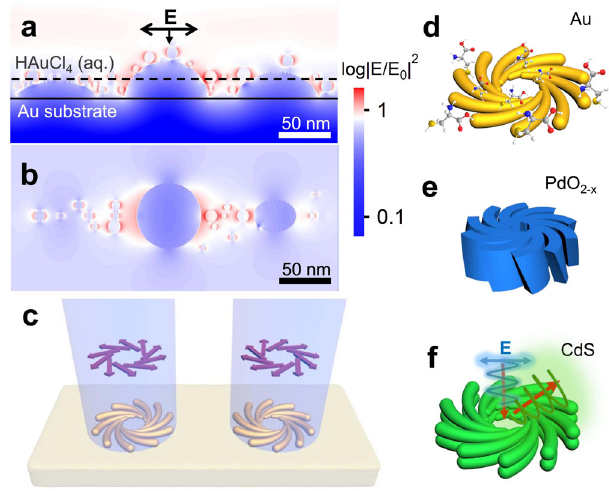
Fig. 1 | Concept of polarization-directed growth of chiral nanosturtures. a , b Near fi eld pro fi les of Au NPs (diameter: 8±4nm) on Au fi lms. a Cross-section view, b Top view. The big ribbons are roughened Au fi lms induced by etching and thesmallspheresareAunanoseedsgeneratedbythelaserirradiation.Thesolidline representsthesurfaceofAu fi lmsandthedashedlineindicatesthecross-sectionof the top view shown in ( b ). c Schematic of spiral nanostructures formed by laser direct writing with vector beams. The purple arrows represent the polarization directions of the vector beam (light blue). d – f Schematic of spiral